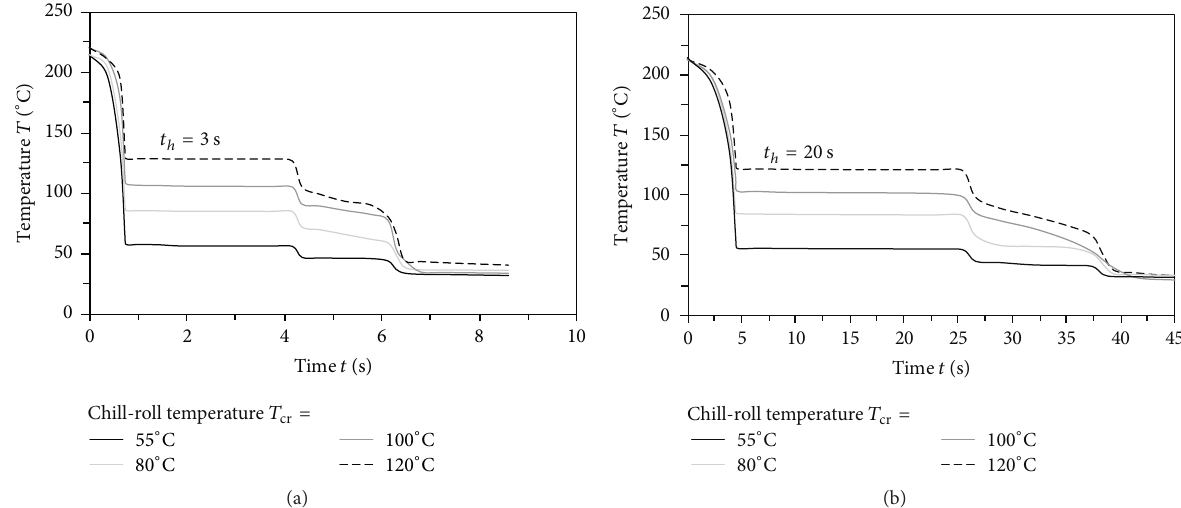
Figure 3: Measured temperature-time profile for the extruded foils measured with IR-camera for an isothermal holding time of 3 s (a) and 20 s (b).